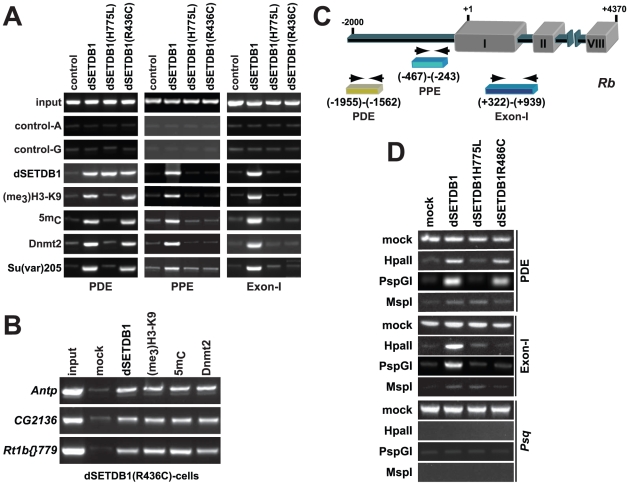
DSETDB1-mediated tri-methylation of H3-K9 propagates spreading of DNA methylation and silencing of Rb.(A) Digital images of ethidium bromide-stained agarose gels showing reaction products for the PDE and Exon-I of Rb indicated in (A) in DNA pools obtained by ChIP. Chromatin was isolated from S2 cells transiently expressing GFP (control) and S2 cells co-expressing GFP and dSETDB1, dSETDB1(H775L), or dSETDB1(R436C). Chromatin was immunoprecipitated with antibodies and agarose beads described in Figure 2C. PCR assays detected the PDE, PPE and Exon-I in immunoprecipitated DNA pools. (A,C) Input represents the amount of target DNA present in 1% of the chromatin used for ChIP. (B) Digital images of ethidium bromide-stained agarose gels detecting the target DNA sequences for dSETDB1 in Antp, CG2136 and Rt1b{}779 (see Figure S9) in DNA pools obtained by ChIP. Chromatin was isolated from S2 cells transiently expressing GFP and dSETDB1(R436C). Chromatin was immunoprecipitated with antibodies and agarose beads described in Figure 2C. (C) Schematic representation of the Rb locus. Boxes mark the position of exons I (Exon-I), II, and VIII. The positions of the promoter distal enhancer element (PDE), promoter proximal enhancer element (PPE), and Exon-I fragments detected in ChIP assays are indicated. (D) Digital images of ethidium bromide stained agarose gels showing the reaction products of methylation-sensitive restriction analyses of genomic DNA isolated from cells described in (B). Genomic DNA was isolated, incubated with bovine serum albumin (BSA) (mock), the methylation sensitive restriction endonuclease HpaII, or the methylation-insensitive restriction enzyme MspI. PCR assays monitored the presence of the PDE, Exon-I, and the promoter region of Peepsqueak (Psq) in treated DNA pools.